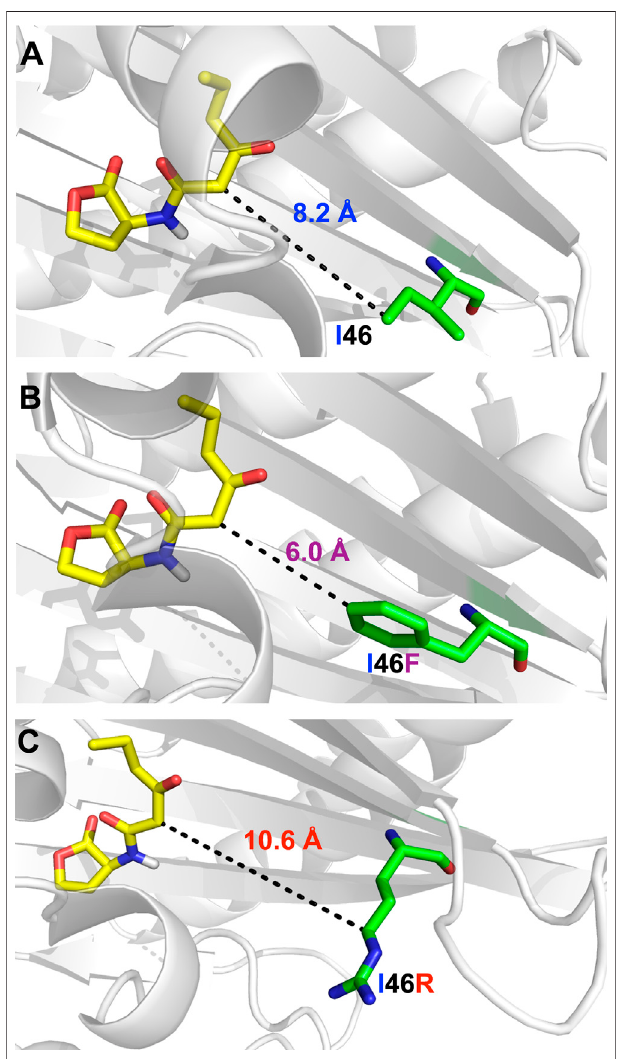
FIGURE 2 | The structural relationship between LuxR residue I46 (A) , mutant I46F (B) and I46R (C) and bound 3OC6-HSL (residue backbones shown in green, 3OC6-HSL backbone in